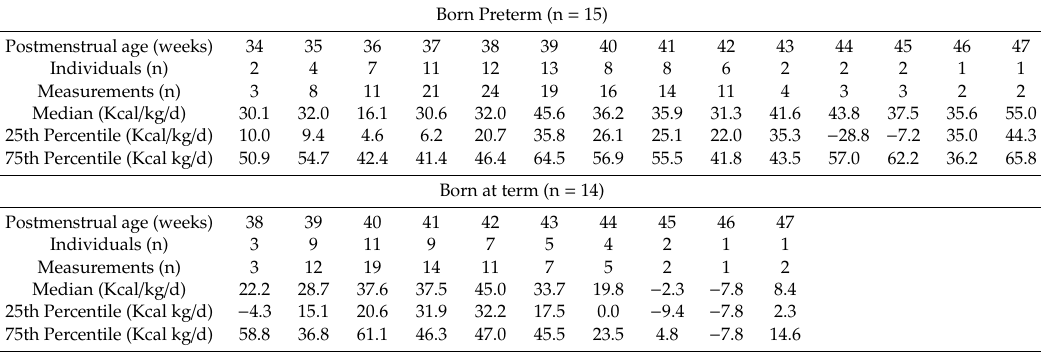
Table 6. Evolution of energy balance (total energy intake minus REE) in infants born preterm and at term REE, resting energy expenditure.